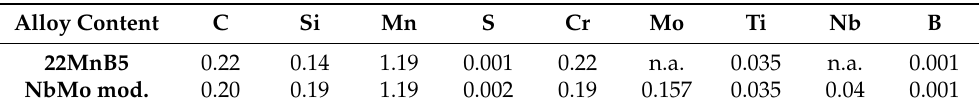
Table 1. Chemical composition of the investigated hot rolled 1500 MPa press hardening steels (numbers in weight percent, n.a.: not added).